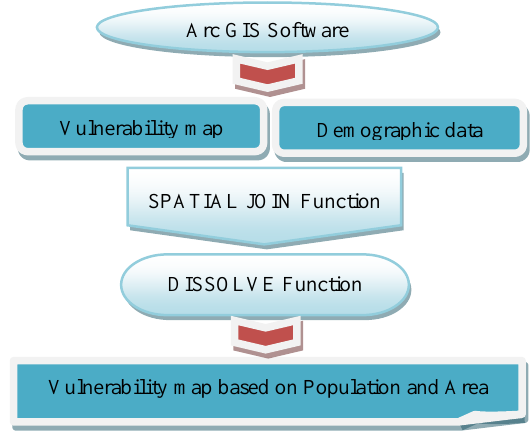
Figure 8. The process of generating vulnerability maps based on population blocks